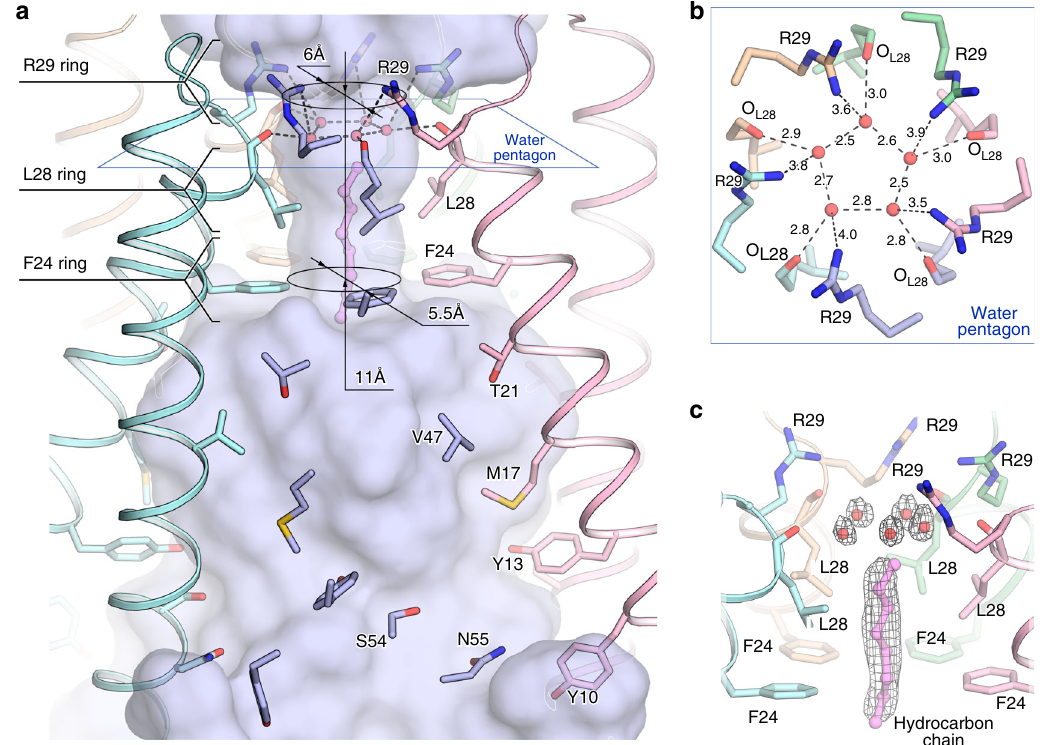
Fig. 2 Central pore inside OLPVRII pentamer. a Overall central pore structure. One protomer is hidden for clarity. The lipid fragment is colored violet. b View from the cytoplasmic side on the water pentagon and interaction network between water molecules and the pore-lining OLPVRII residues. c Side view of the pore vestibule. Example of 2Fo-Fc electron density map is shown around the water pentagon and the hydrocarbon chain. The map is contoured at the level of 1.2 σ . The hydrocarbon chain is colored